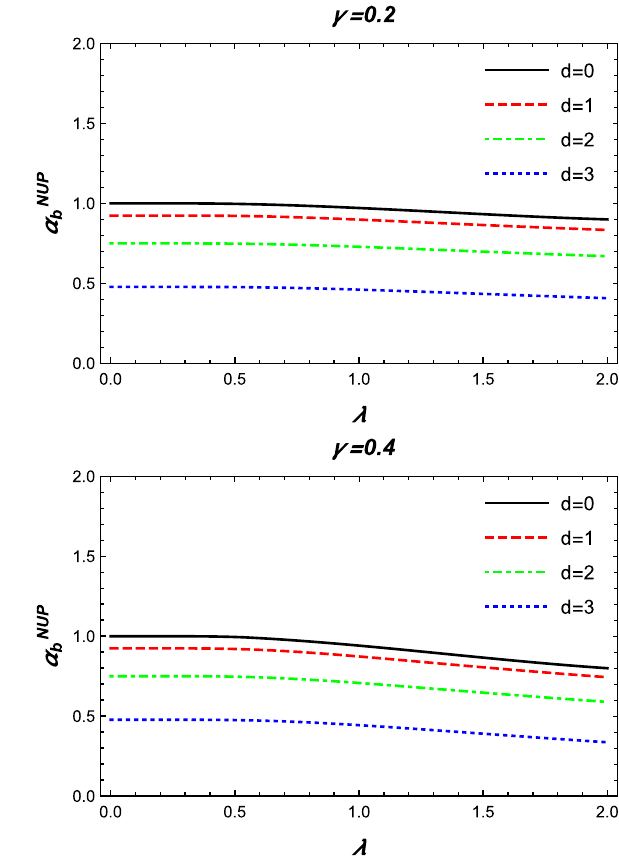
Fig. 17 α b for different value d in the non uniform plasma ( M = 1 , b = 4)